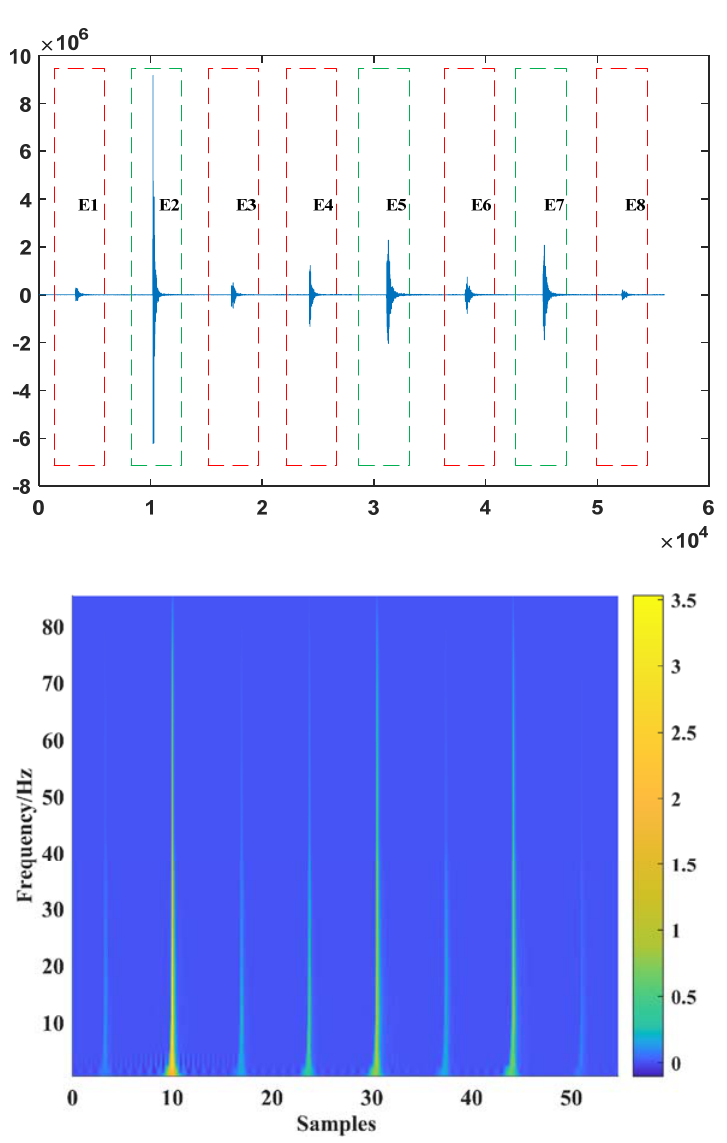
Figure 7. Microseismic signal for experiments and its scattergram of time-frequency analysis .